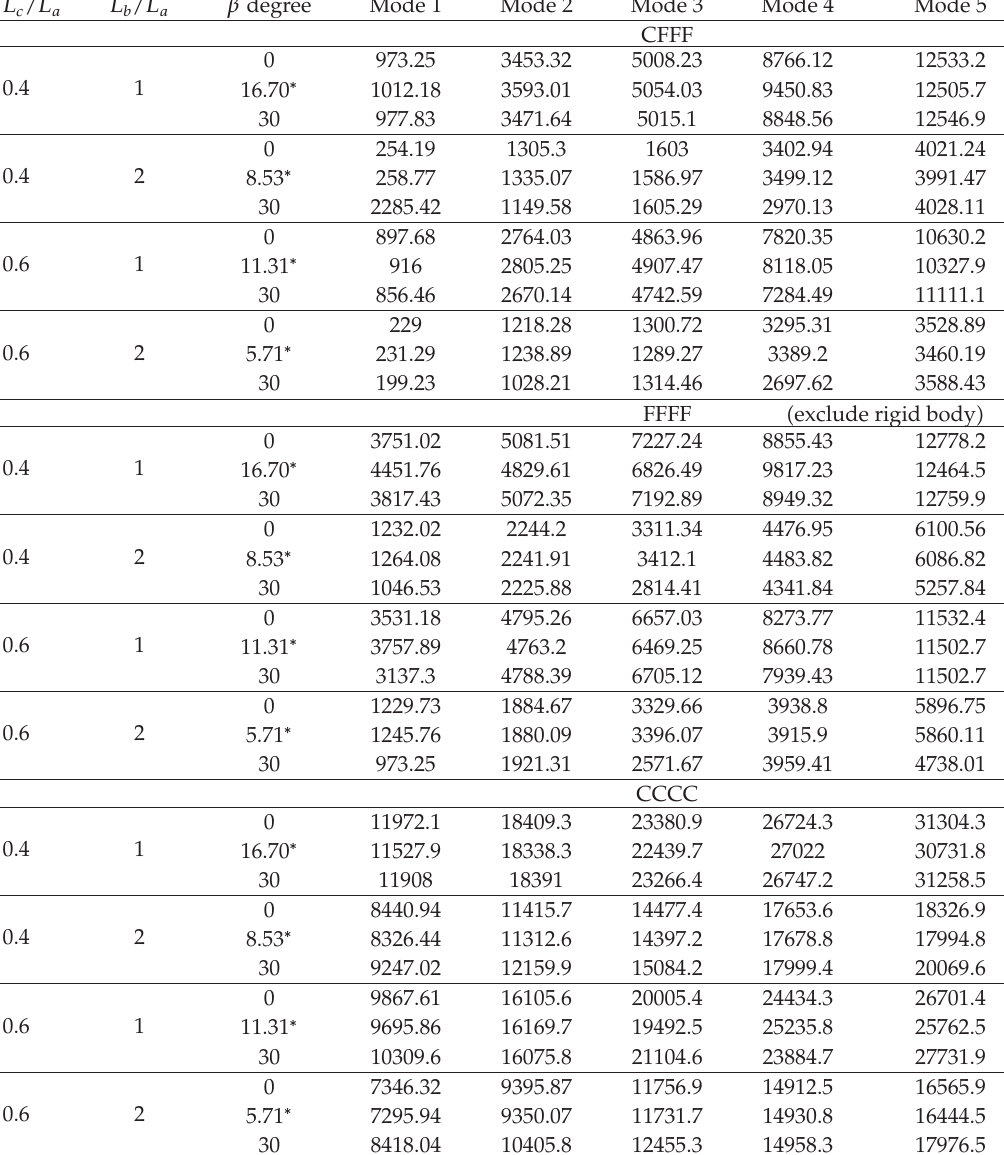
Table 5: Natural frequencies (cid:3) Hz (cid:6) of the aluminum trapezoidal plates with a top and a bottom PZT-5H